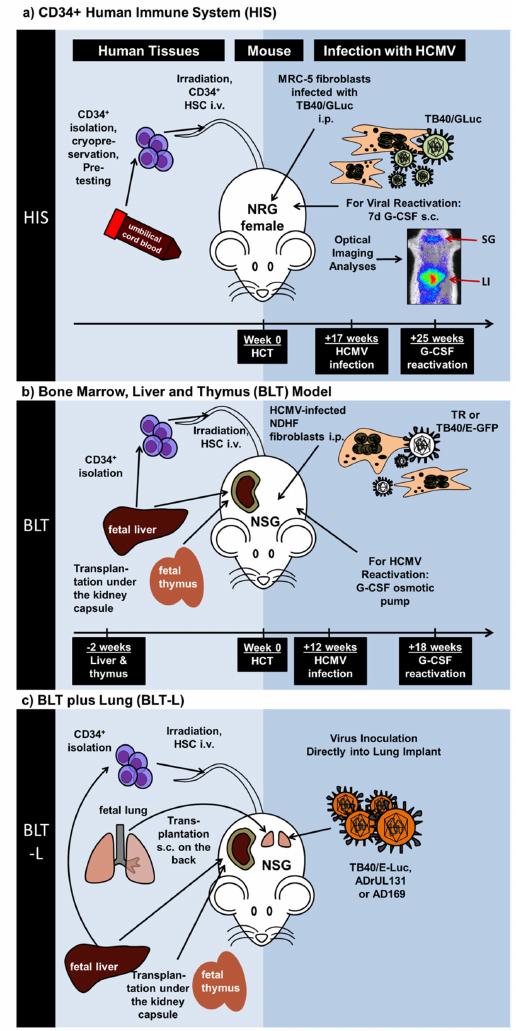
Figure 1. Schematic representation of recently described humanized mouse models exploring engraftment of di ff erent human tissues, immune-deficient mouse strains, and HCMV laboratory or clinical strains. ( a ) Mice with a human immune system (Theobald et al. (2018)). Cord blood-isolated CD34 + hematopoieticstem cellsweretransplantedi.v. into Nod.Rag.Gamma(NRG)mice. Seventeen weeks later, NRG mice with a developed human immune system (NRG-HIS) mice were administered i.p. with MRC-5 fibroblasts infected with the HCMV TB40 strain expressing Gaussia luciferase (GLuc). Eight weeks after infections, mice were administered daily with G-CSF s.c. for seven days to promote HCMV reactivation. Optical imaging analyses demonstrated the spread of the virus in di ff erent body parts such as liver (LI) and salivary glands (SG). ( b ) Bone marrow, liver and thymus (BLT) model (Crawford et al. (2017)). Human fetal tissues (liver and thymus) were used to generate the BLT model. Liver and fetal tissues were implanted under the kidney capsule of Nod.Scid.Gamma (NSG) mice. Two weeks later, CD34 + hematopoietic stem cells isolated from the liver were transplanted i.v. Twelve weeks after stem cell transplantation, NSG-BLT mice engrafted with the human tissues and developing human immune cells were administered with human non-dermal human fibroblasts (NDHF) infected with HCMV (strains TR or TB40-E-GFP). Six weeks after infections, an osmotic pump delivering G-CSF was used to promote HCMV reactivation. ( c ) BLT plus Lung (BLT-L) Model (Wahl et al. (2019)). Human fetal tissues (liver, thymus, lung) were implanted into Nod.Scid.Gamma (NSG) mice and CD34 + cells isolated from liver were used for stem cell transplantation. At various time-points after tissue engraftments, HCMV (strains TB40 / ELuc, ADrUL131, or AD169) was inoculated directly into the engrafted